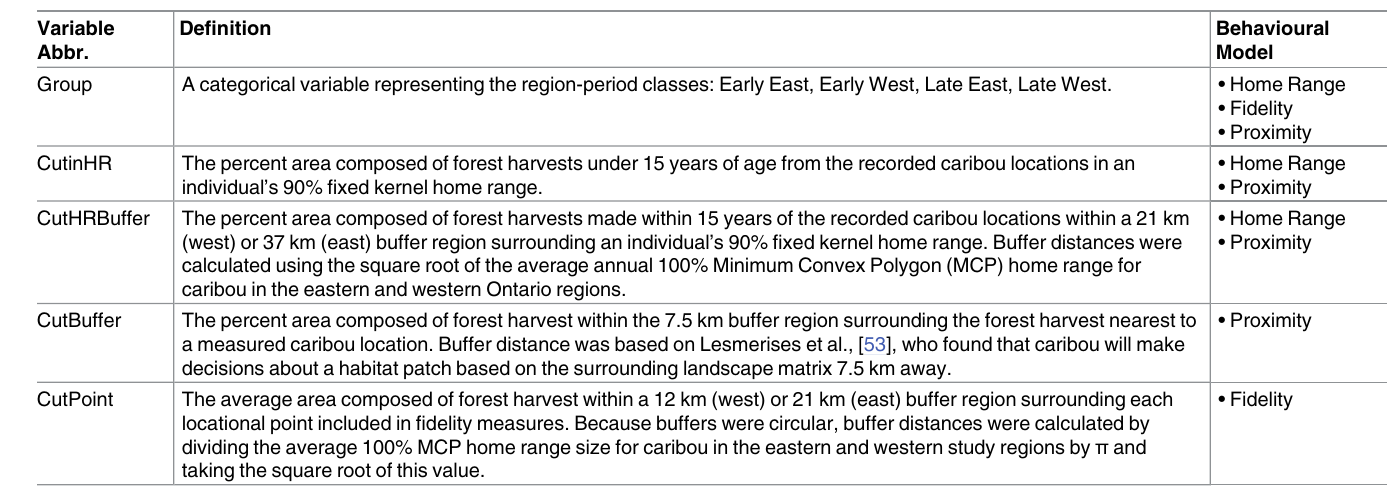
Table 1. Caribou behaviour model